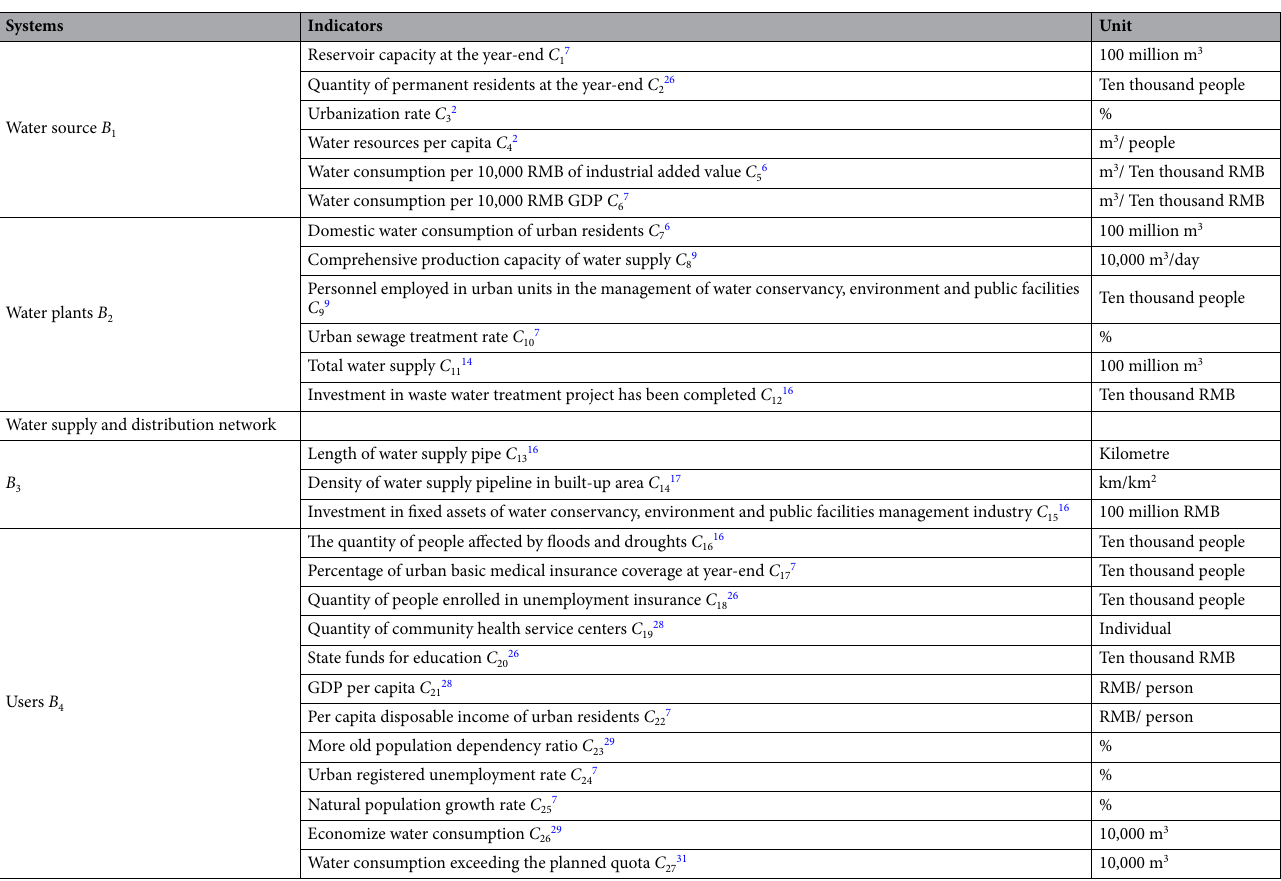
Table 3. Urban water supply system index classification.